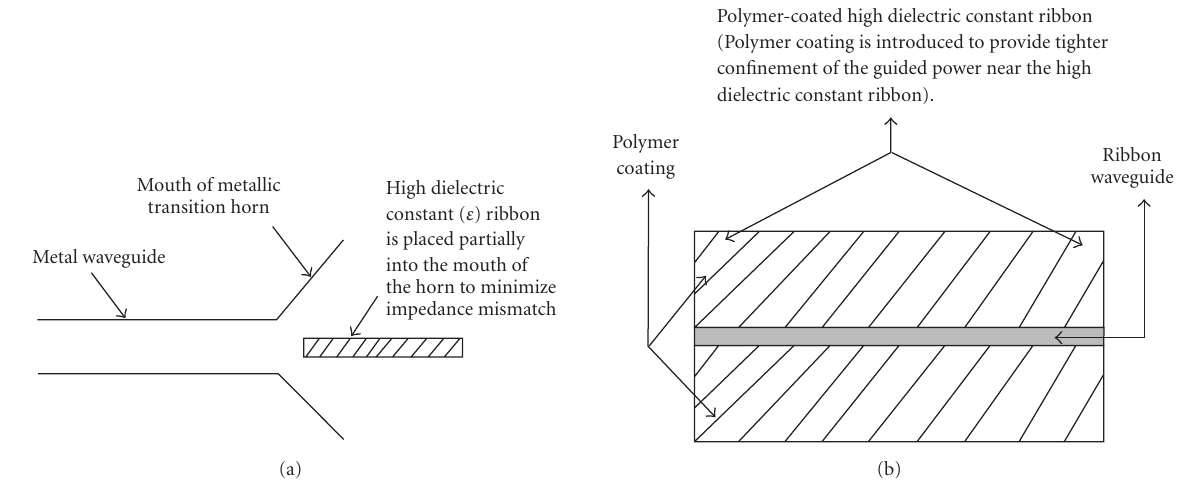
Figure 7: (a) Rectangular metal waveguide to high dielectric constant ribbon waveguide transition [17]. (b) Longitudinal cross-sectional geometry of a polymer-coated high dielectric constant ribbon. The thickness and the width of the high dielectric constant ribbon are 0.0635 λ 0 and 0.635 λ 0 , respectively. The thickness of the polymer coating is approx. 0.25 λ 0 , and the width is approx. 0.635 λ 0 . The dielectric constant of the ribbon is 10 while that of the polymer is 2.04 [17].